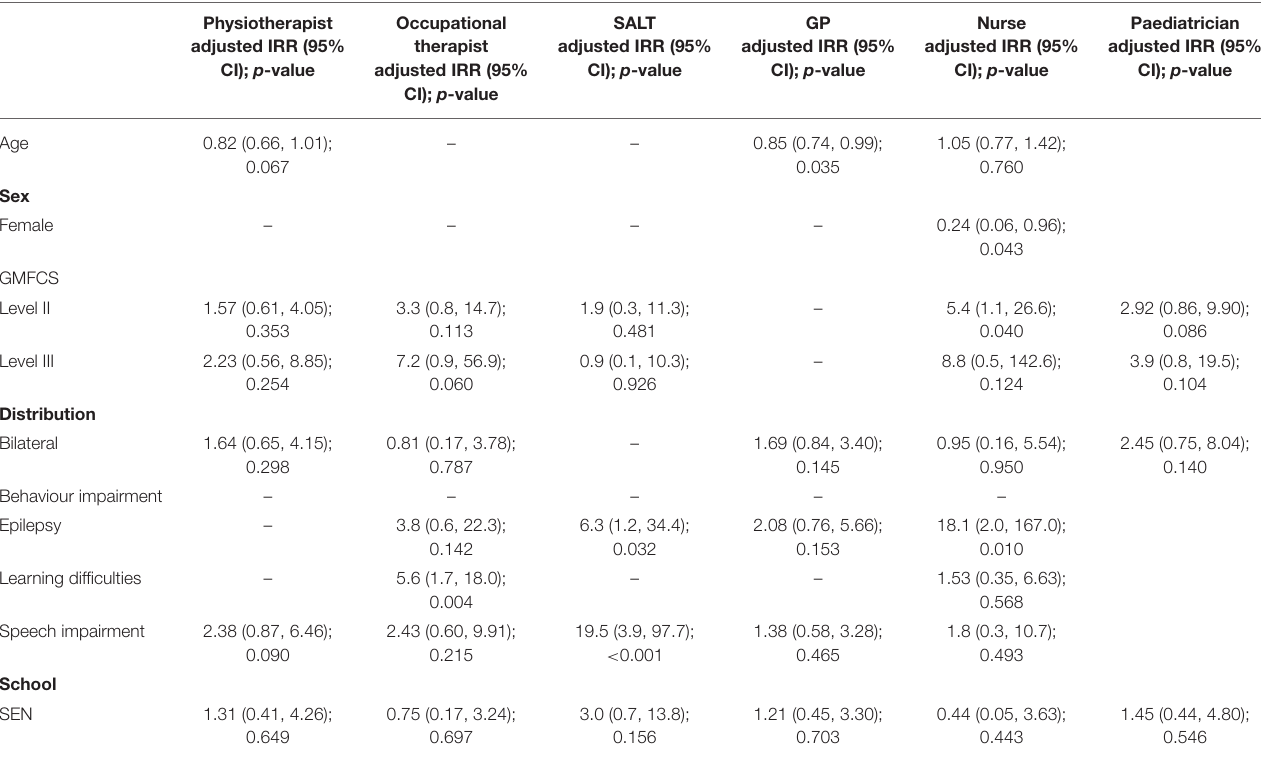
TABLE 8 | Adjusted associations with number of visits to a physiotherapist, occupational therapist, speech and language therapist, general practitioner, nurse,